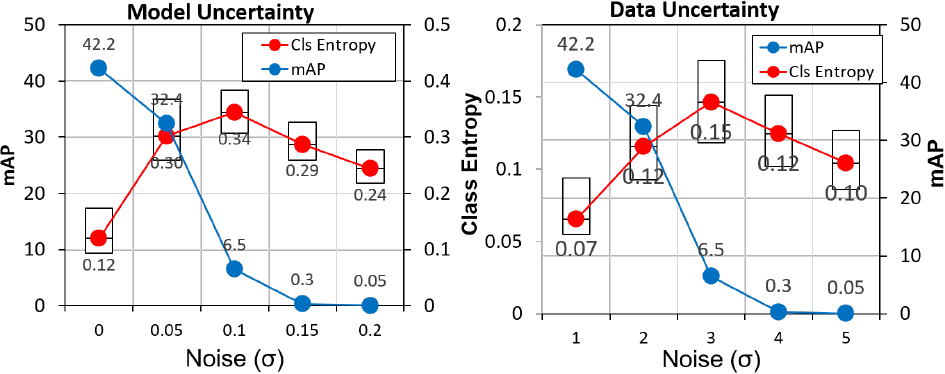
Figure 8. Model and Data Classification Uncertainty estimates for an object detection model on the CAMEL dataset. Reprinted with permission from ref. [12]. Coprright 2020